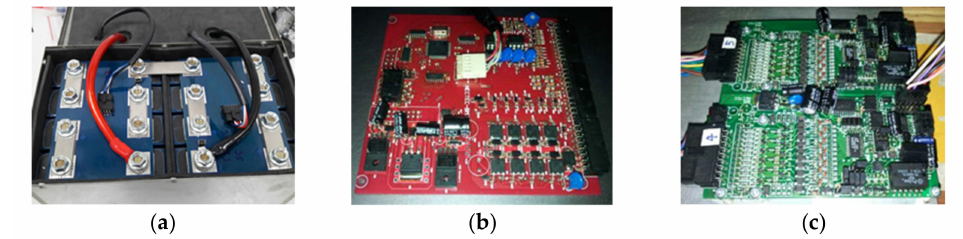
Figure 17. ( a ) Lithium ion battery pack; ( b ) master board of the battery management system; ( c ) cell monitoring board of the battery management system.